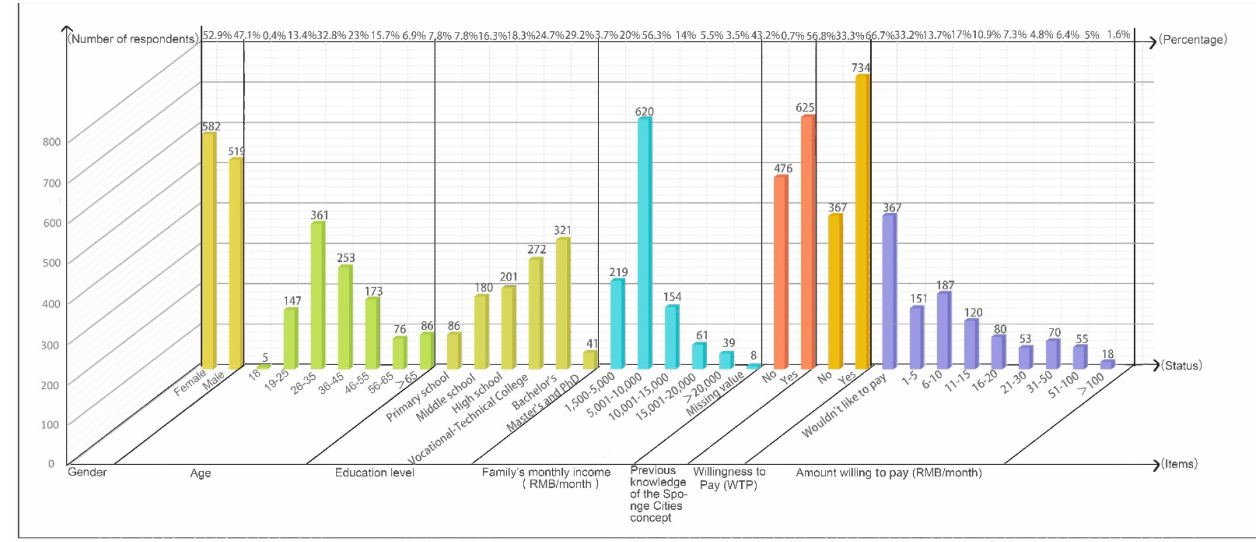
Figure 2. Profiles of respondents’ demographic information and WTP.